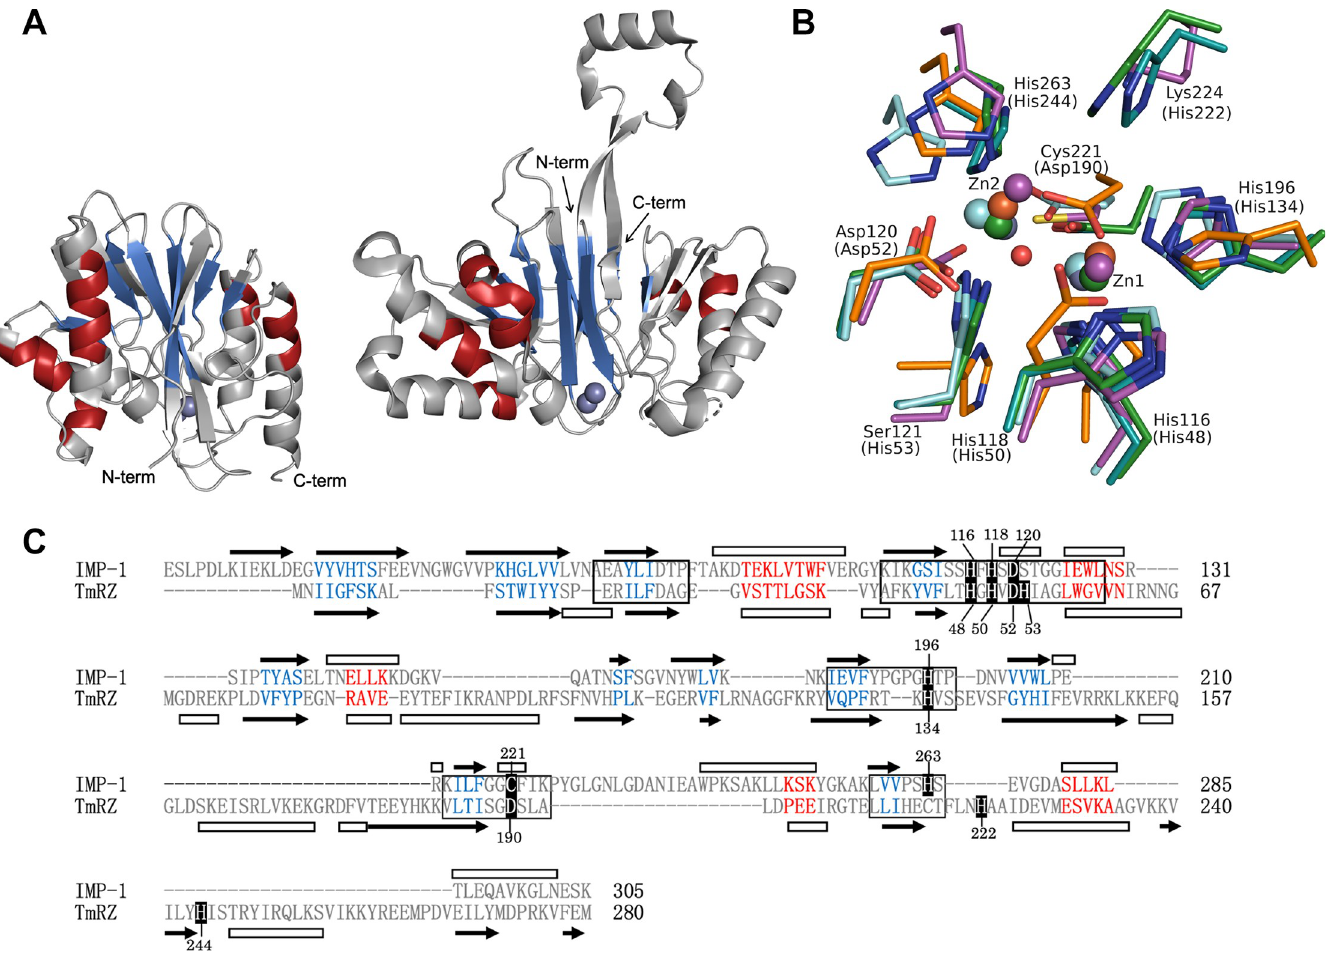
Fig 4. Comparison of the tertiary structures of IMP-1 and TmRZ, and structure-based alignment. (A) Overall structures of IMP-1 (left) and TmRZ (right) in the same orientation. (B) Comparison of metal-binding active sites of MBL superfamily enzymes: IMP-1 with Zn 2+ (violet), TmRZ with Zn 2+ (blue), quinolone signal response protein PqsE with Fe 3+ (2Q0I, cyan), rubredoxin oxygen:oxidoreductase with Fe 2 O (1E5D, orange), and FAD photoproduct diphosphatase with Mn 2+ (6B9V, green). Metal ions and an oxygen of Fe 2 O are shown as spheres. The amino acids involved in the coordination of Zn 2+ are labeled with and without parentheses to indicate residues from TmRZ and IMP-1, respectively. (C) Alignment of primary structures based on a structural comparison using the Dali algorithm [24]. Secondary structures are indicated by black arrows ( β -strands) and white bars ( α -helices). The five conserved segments of the MBL superfamily are boxed. Residues coordinated to zinc ions are shown in white letters against a black background, with their residue numbers. In the figures A and C, the corresponding secondary structure elements are colored in red ( α -helix) and in blue ( β -strand). The figures A and B were generated by The PyMOL Molecular Graphics System, Version 2.0 (Schro¨dinger, LLC).